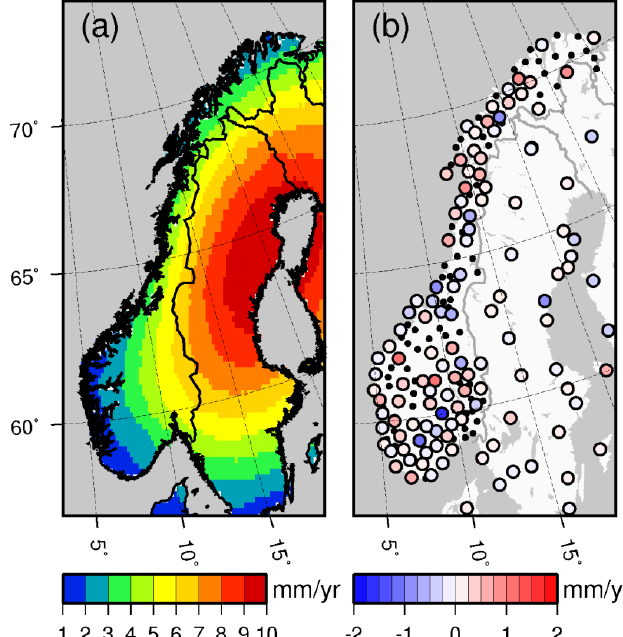
Figure 6. Vertical land motion determined from least-squares collocation of the levelling and GPS observations for: ( a ) our mean solution; and ( b ) the residuals (GPS observations—mean solution). Black dots mark stations with less than three years of data, these observations are not included in this study as they are considered unreliable.